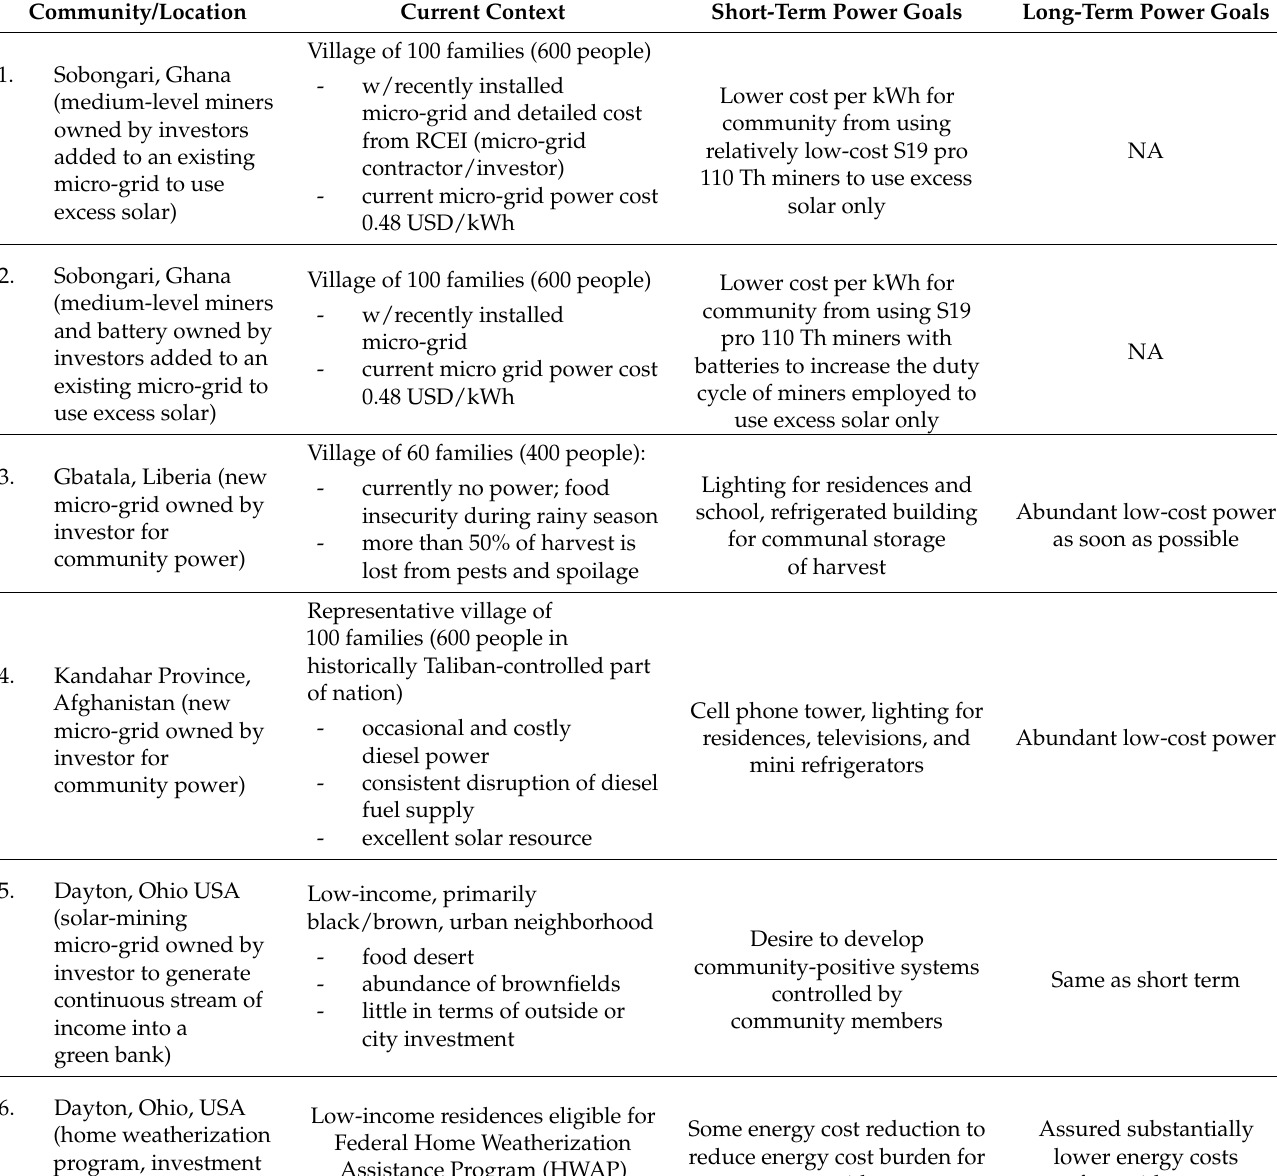
Table 1. Case study context and goals for various scenarios for ‘impact